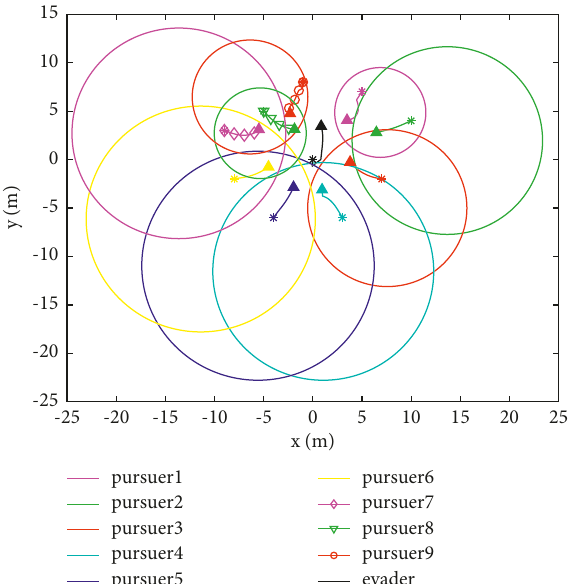
Figure 10: Trajectories of players with the pursuit strategy pro- posed in [8] ( N � 9, λ � 0 . 75). The pursuers cannot capture the evader.